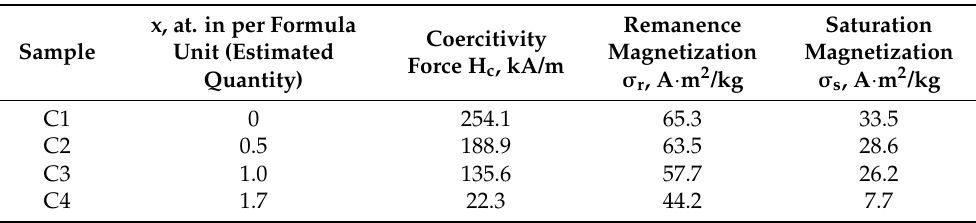
Table 4. Magnetic properties of SrFe 12 − x In x O 19 samples obtained by the citrate method and annealed at 1200 ◦ C for 1 h.